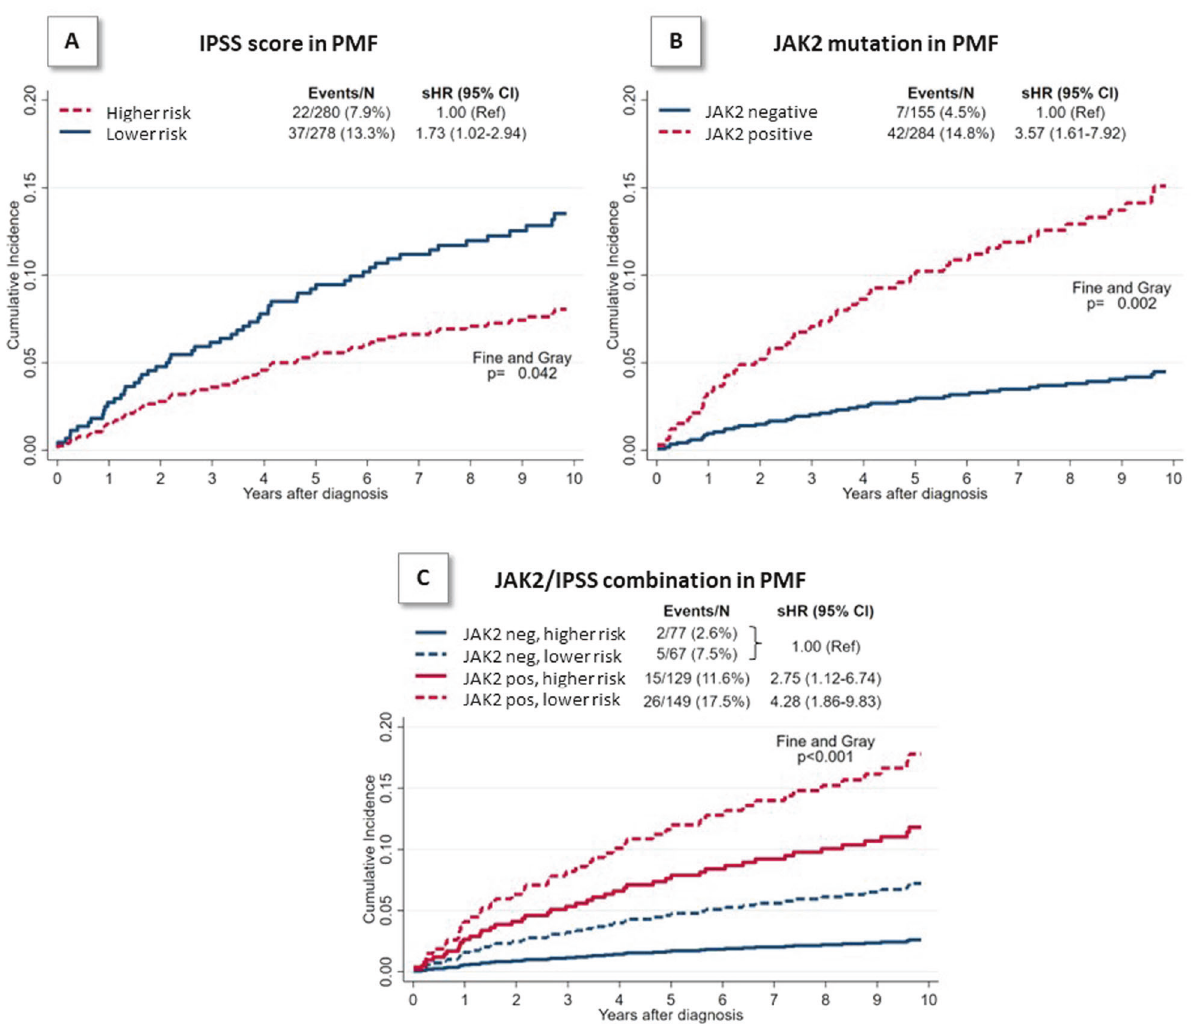
Fig. 2 10-year Cumulative Incidence Function (CIF) of total thrombosis (death was considered as a competing event). Cumulative incidence of thrombosis was represented according to IPSS score (panel A ), JAK2 mutation (panel B ) and their combination (panel C ) Lower risk = low and intermediate-1 IPSS categories. Higher risk = Intermediate-2 and high IPSS